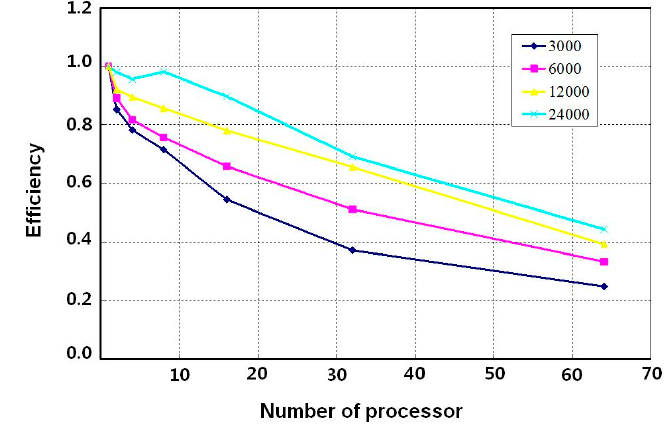
Figure 8. Speed-up according to the number of nodes and processors.